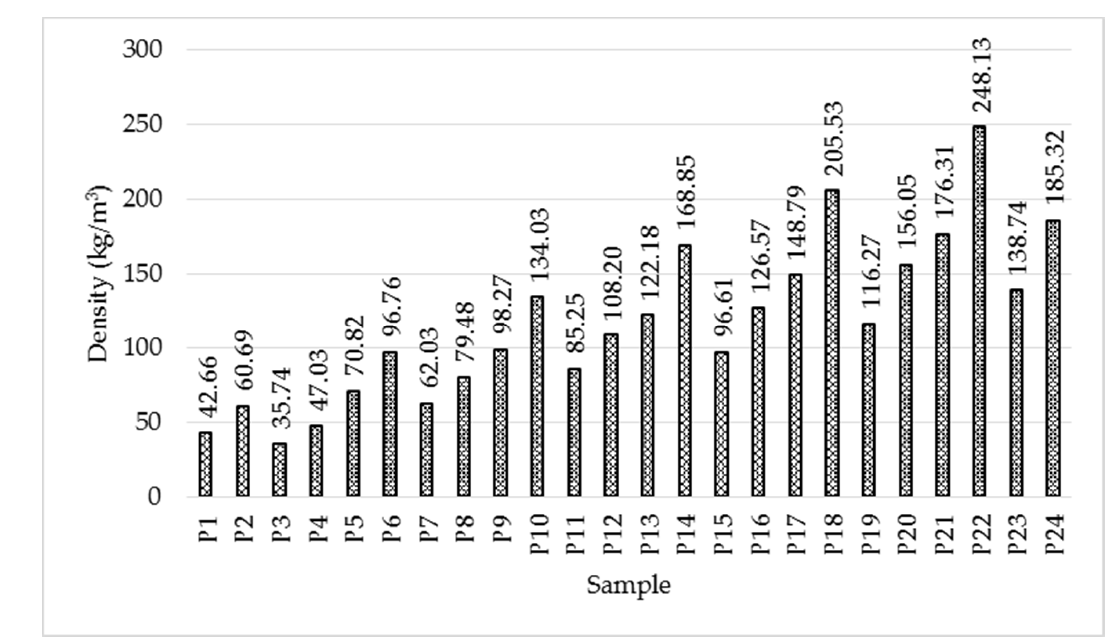
Figure 9. Variation of density of the tested samples; average values.